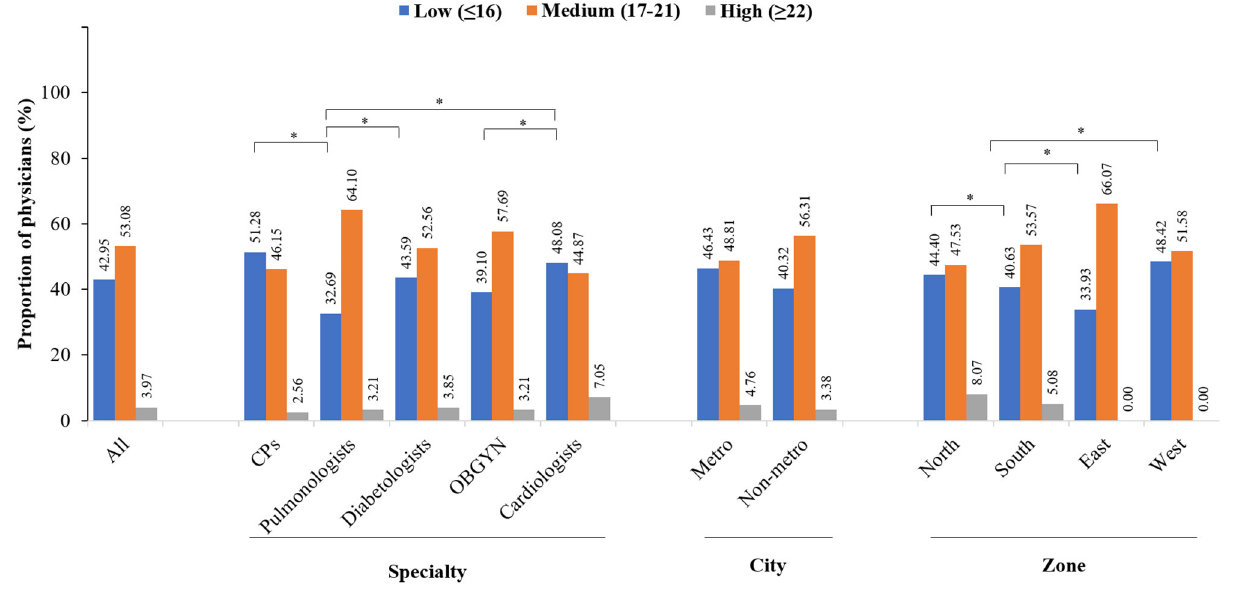
Frontiers in Public Health |